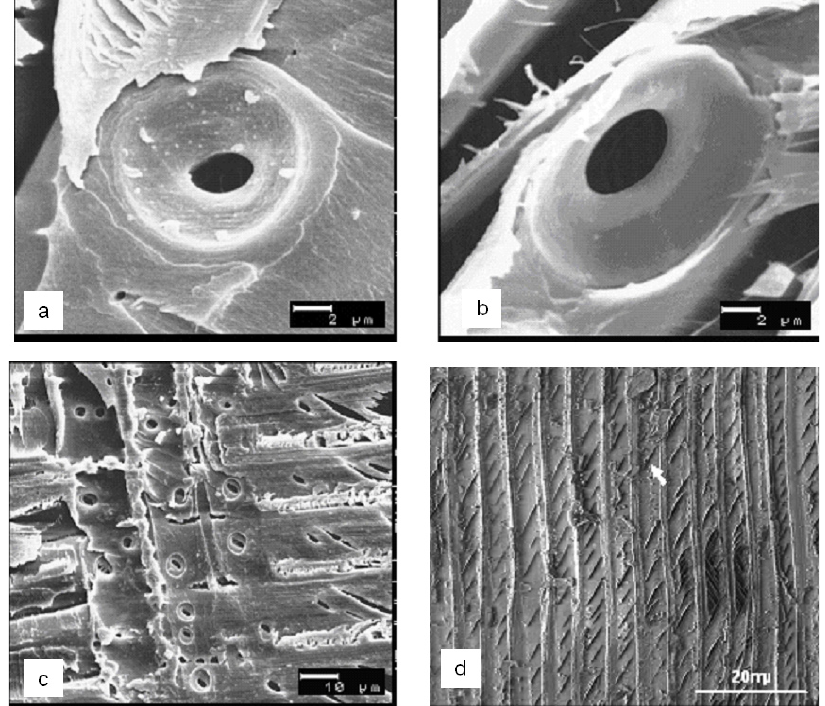
Fig. 4. SEM micrographs of bordered pits on radial side of longitudinal tracheids in compression and opposite wood of Picea abies . A small bordered pit in compression wood (a) vs. a larger one in opposite wood (b). Non-contacting bordered pits with slit-like apertures in compression wood (c). Helical fissures on the radial side of longitudinal tracheids in compression wood